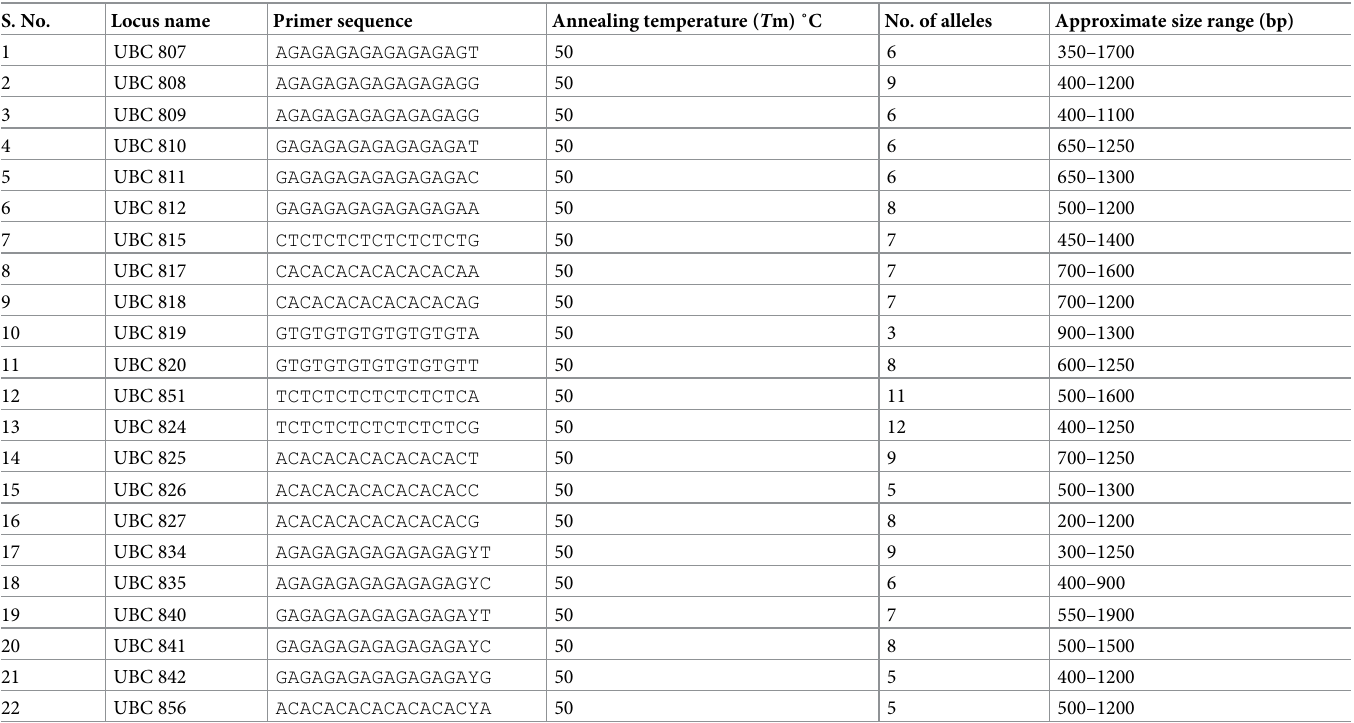
Table 1. List of primers and their amplification